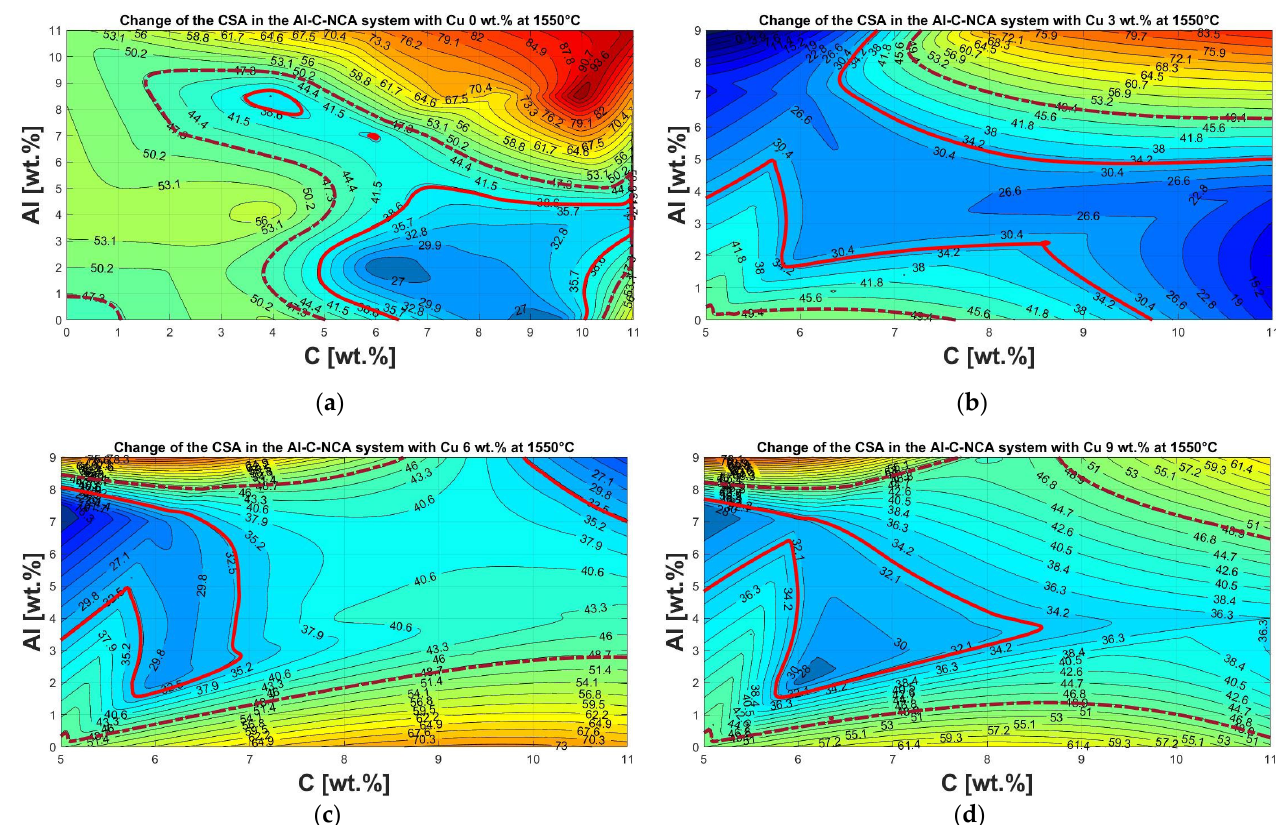
Figure 13. Representation of the change in cross-sectional area from the heating microscope with changing composition of the Al-C-NCA system at 1550 °C in a height stratification plot: ( a ) without addition of Cu; ( b ) constant Cu content of 3 wt.%; ( c ) constant Cu content of 6 wt.%; ( d ) constant Cu content of 9 wt.%.